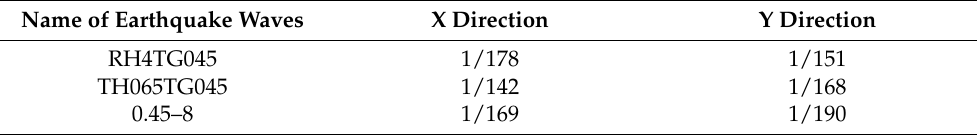
Figure 9. Storey drifts under the three rare earthquake waves. ( a ) X direction. ( b ) Y direction. Table 17. The maximum values of the storey drifts under the three earthquake